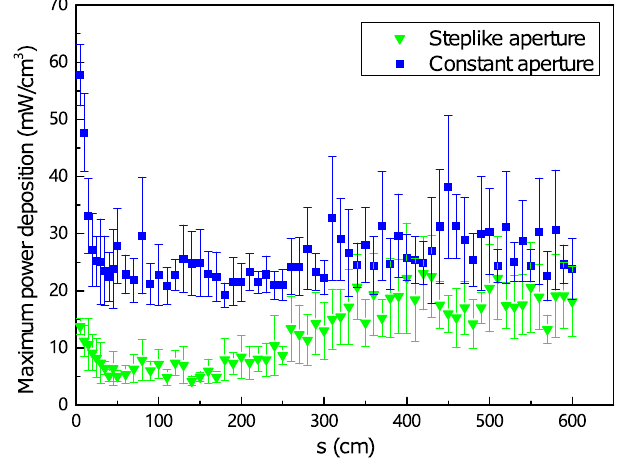
FIG. 14. Maximum power deposition density along the QD after the primary collimators.